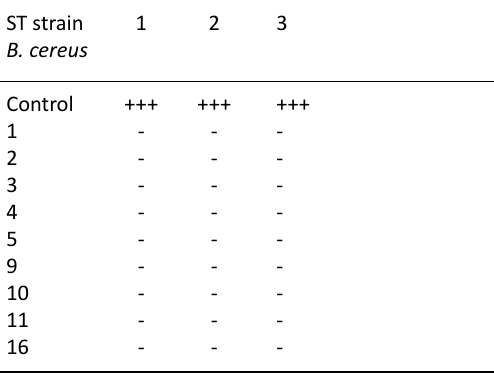
Table 6. Growth of B. cereus ST strain in presence of cadmium CdCl after plasmid curing: 2